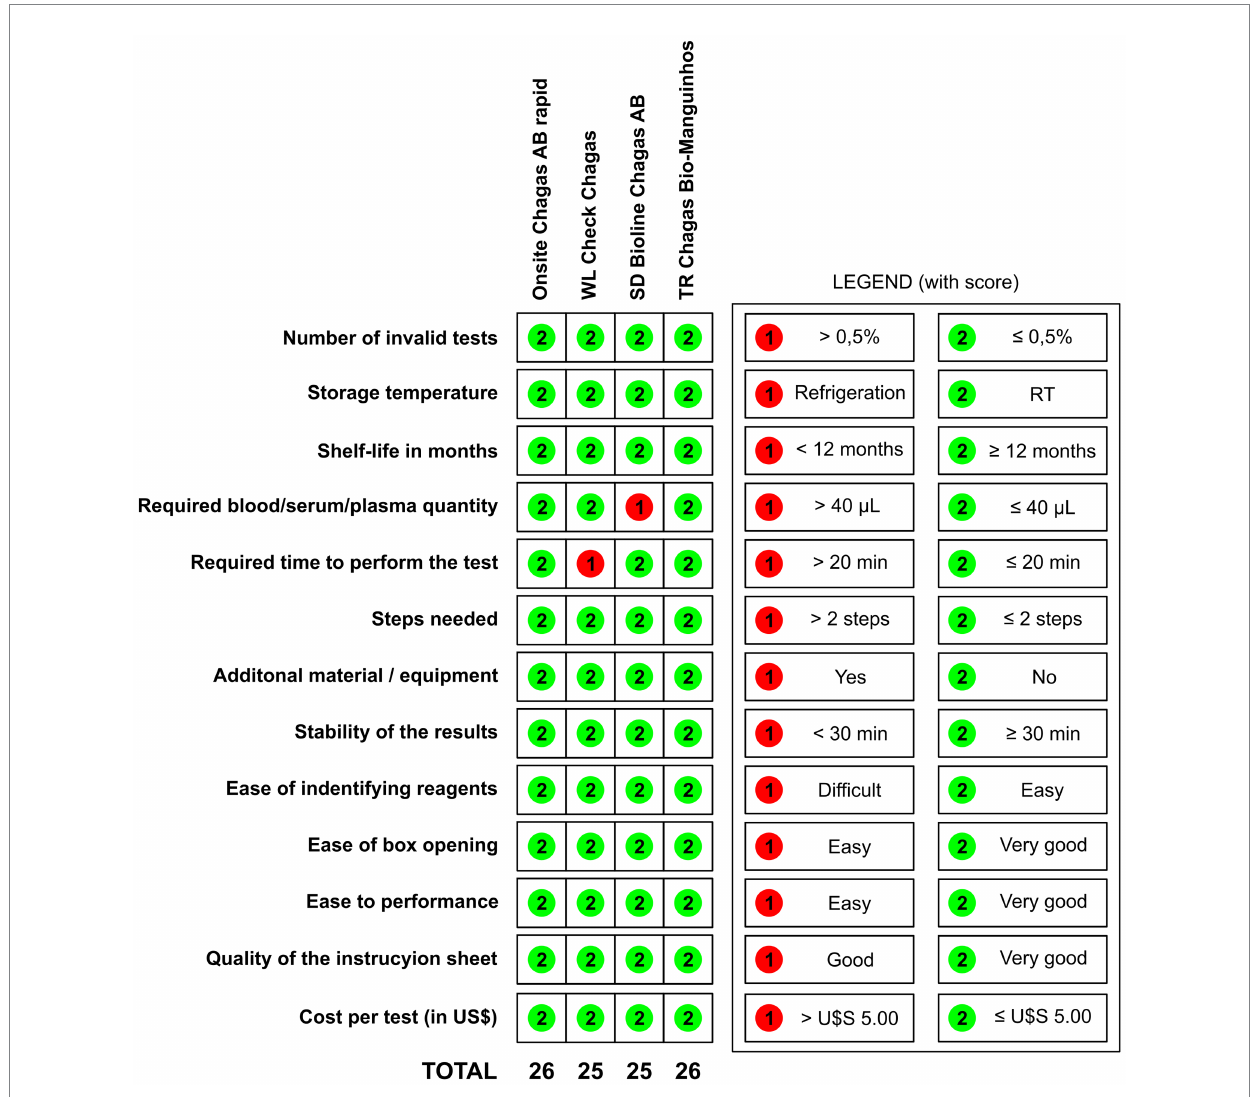
FIGURE 3 Validity and inter-reader reliability of four rapid diagnostic tests for the detection of IgG anti- Trypanosoma cruzi . RT (room